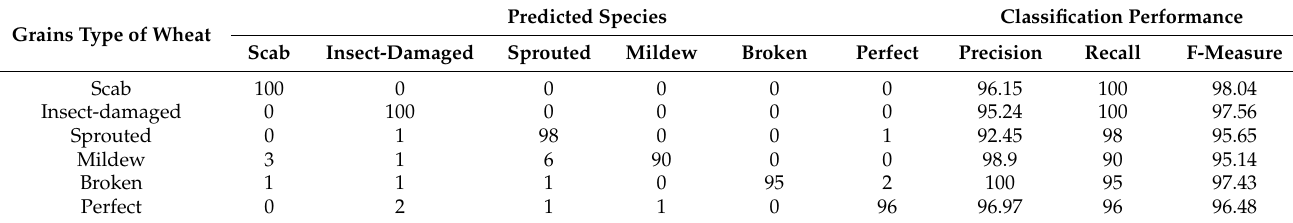
Table 4. Confusion matrix and classification performance of the ResNet-50 model with attention. Grains Type of